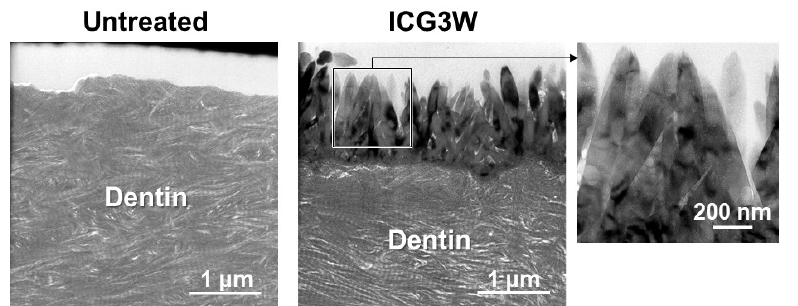
Figure 4. Cross-sectional TEM images of the surfaces of the untreated substrate (left) and LAB-pro- cessed substrate: ICG3W (middle, right), with lower (left, middle) and higher (right) magnification. substrate: ICG3W (middle, right), with lower (left, middle) and higher (right)